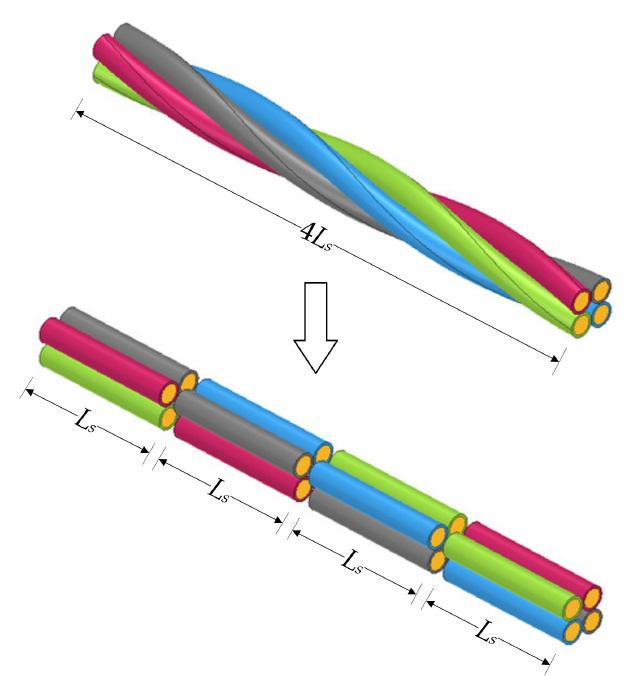
Figure 2. The simplified structure of the four twisted conductors.